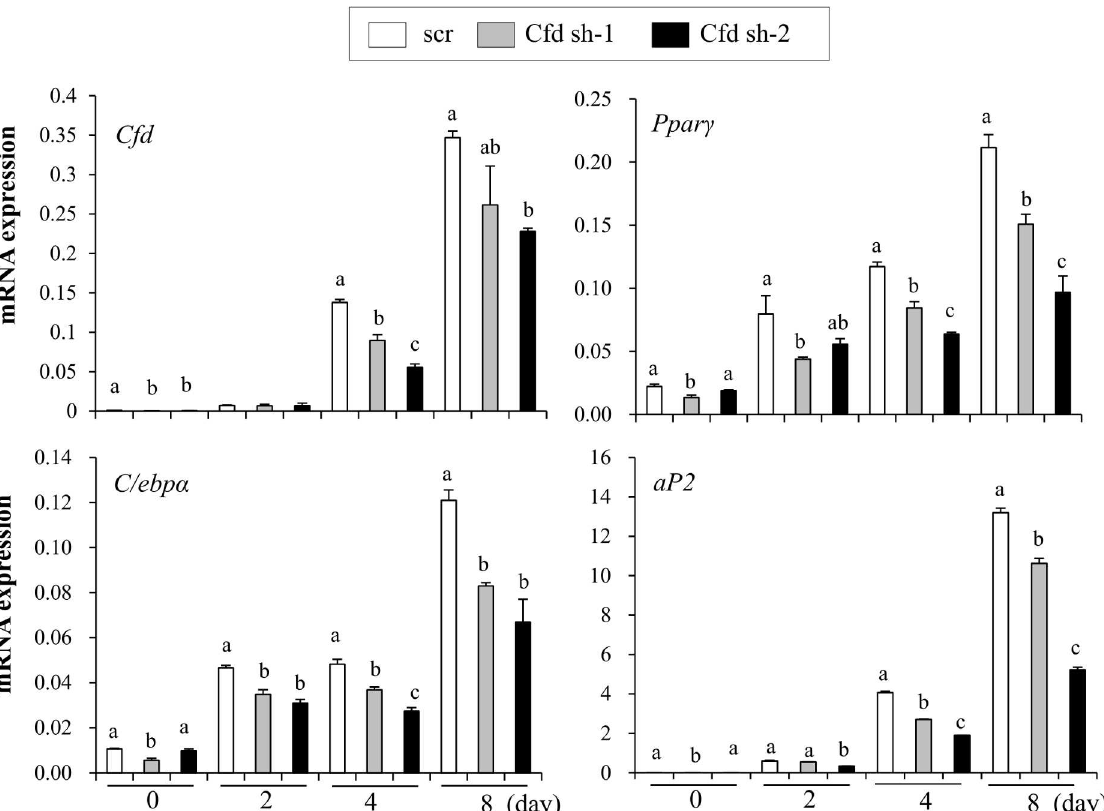
Fig 3. Silencingof Cfd suppresses adipocyte differentiation. Stable C3H10T1/2cells expressing two independent shRNAs against Cfd or scrambled shRNA were generated. Stable cells were differentiated into adipocytesfor 8 days and expression of Cfd , Ppar γ , C/ebp α ,and aP2 was measuredby real timePCR analysis. Data are presentedas means +/- s.e.m. and are representativeof two independent experiments. Each independent experiment was carriedout in triplicate.Statistical significance differences were determined using one- way ANOVA and the Student-Newman-Keuls test.Different letterat each samples are significant( P <